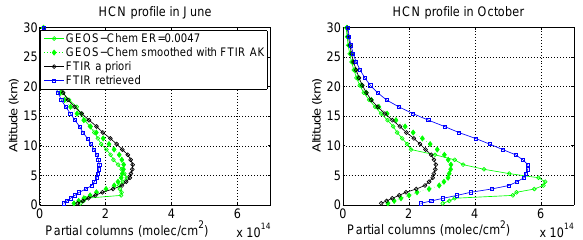
Fig. 7. Example of FTIR and GEOS-Chem HCN profiles (in Partial Columns, moleccm − 2 ) in June and